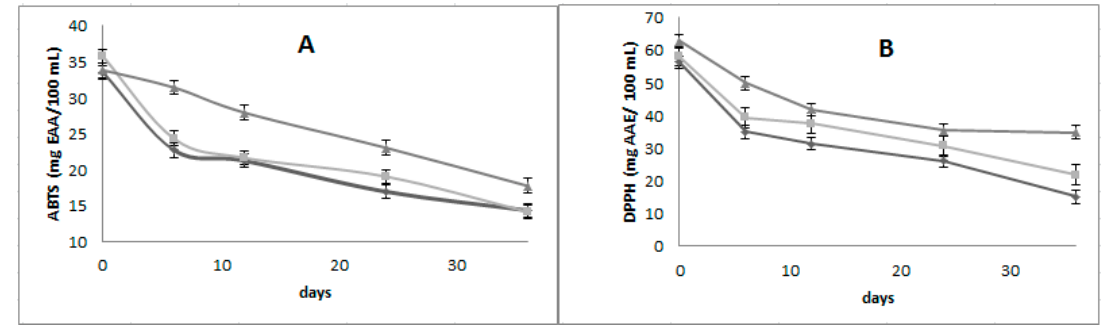
Figure 2. Content of total phenol ( A ), total flavonoids ( B ) and betalains; ( C ) of three multiple emulsions formulated with two polymers, arabic gum (GA) and maltodextrin (MD): AG40%-MD60% AG50%-MD50% and AG60%-MD40% during 36 days of storage.